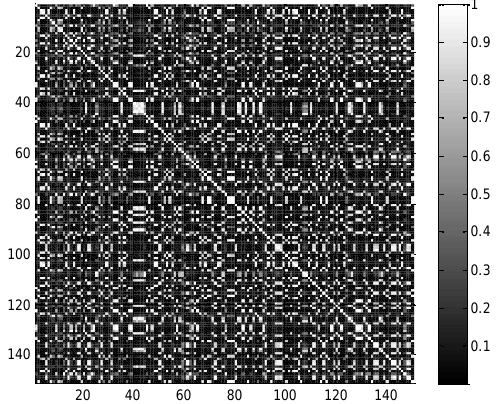
Fig. 5. The similarity matrix W : the larger the similarity, the brighter the shade of the ij -th element.